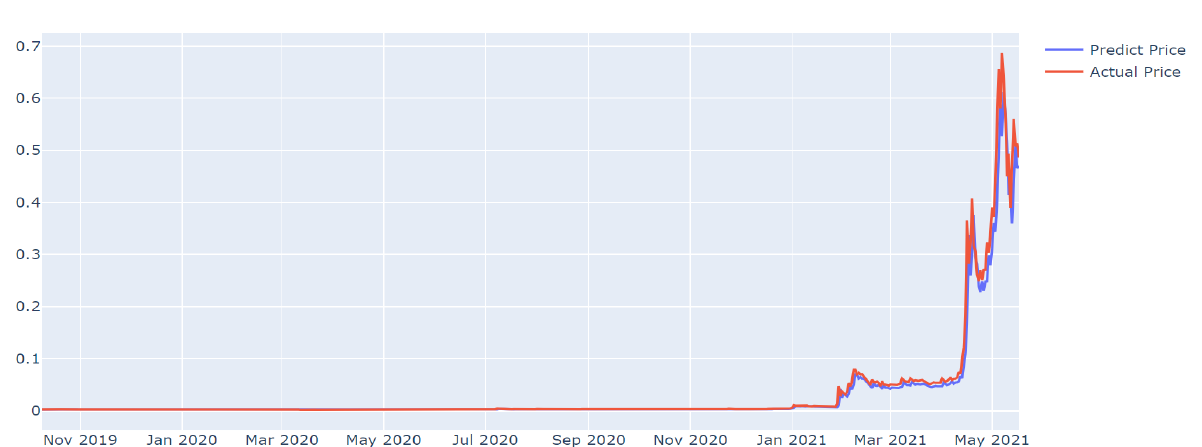
Fig. 9. Price prediction graph when complete feature vector (as discussed above) is used